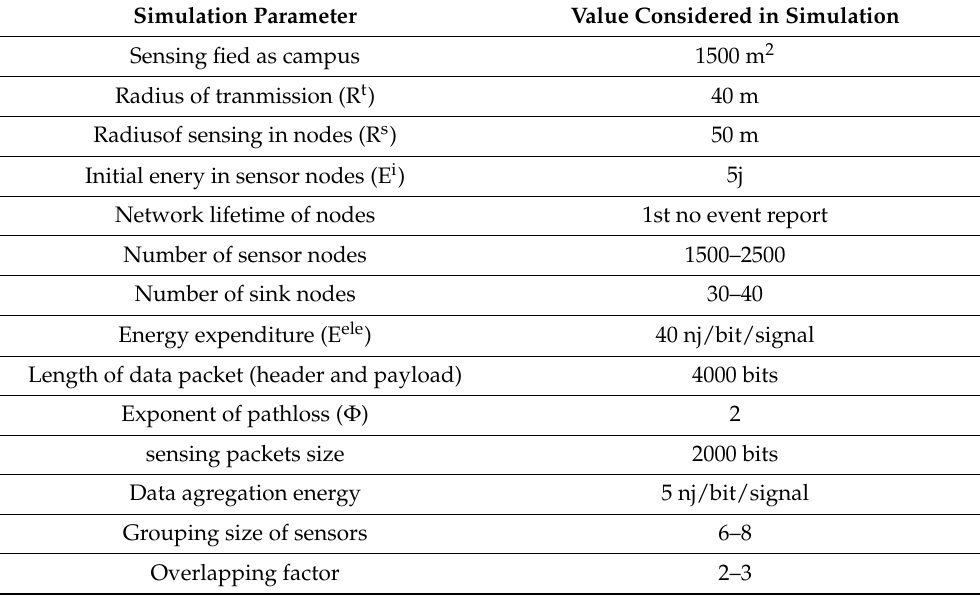
Table 1. Major simulation